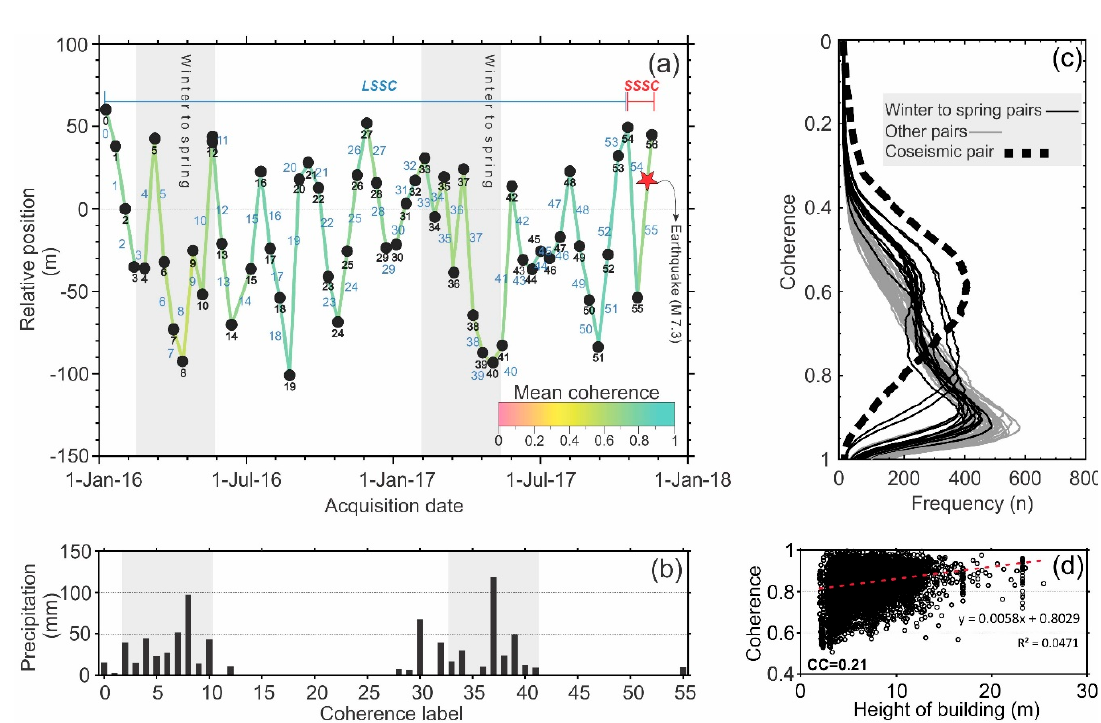
Figure 3. ( a ) Chain-like formation of coherence analysis for the long sequential SAR coherence (LSSC) and short sequential SAR coherence (SSSC). The black circles and numbers are the Sentinel-1 images and the corresponding numbers of the images. The colored lines and blue numbers are associated with the mean coherence values and the corresponding numbers of the coherence map; ( b ) Daily precipitation graph recorded at Kermanshah station (Lat: 34.26, Lon: 47.11). The coherence labels are the blue numbers in Figure 3a; ( c ) Histogram of Sarpole-Zahab in each produced coherence map; ( d ) Correlation between the heights of individual buildings and the corresponding coherence values in Sarpole-Zahab.